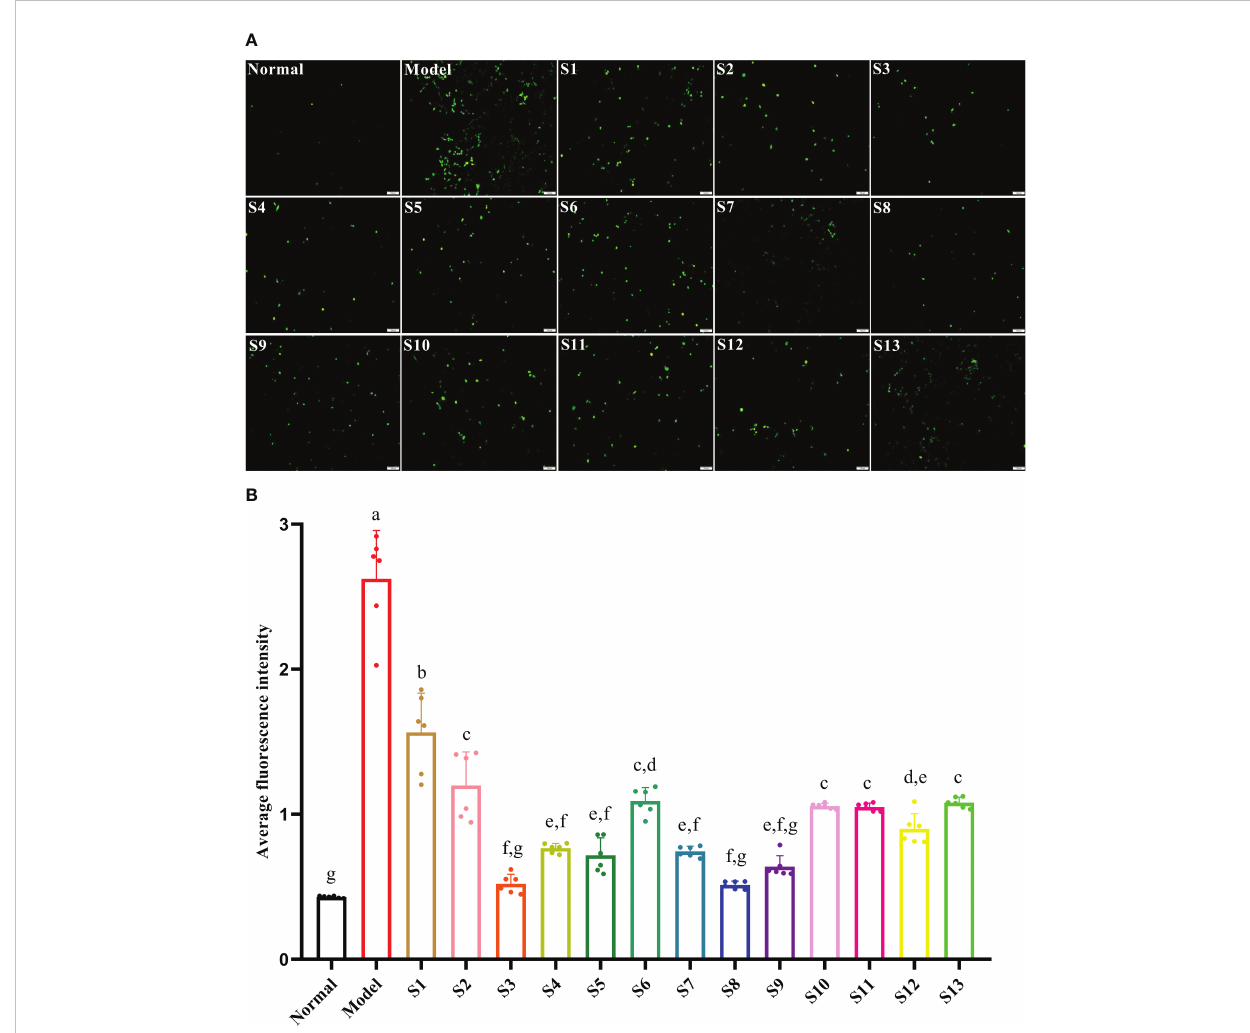
FIGURE 3 Mulberry branch can reduce the apoptosis of rat brain microvascular endothelial cells (RBMECs) in hyperglycemia and hyperlipidemia. S1, Mulberry leaf; S2, Heilongjiang; S3, Liaoning; S4, Hebei; S5, Shanxi; S6, Henan; S7, Jiangsu; S8, Anhui; S9, Zhejiang; S10, Sichuan; S11, Yunnan; S12, Guangxi; S13, Guangdong. (A) , Fluorescence probe DCFH-DA was used to detect the level of reactive oxygen species (ROS) generated owing to hyperglycemia and hyperlipidemia in an in vitro model after treatment with different branch extracts for 24 h; (B) , Quantitative analysis of cell fl uorescence intensity of different mulberry branch extracts treated for 24 h. The same letter in the two groups of data indicates no signi fi cant difference. Different letters in the two groups of data indicate a signi fi cant difference ( p <